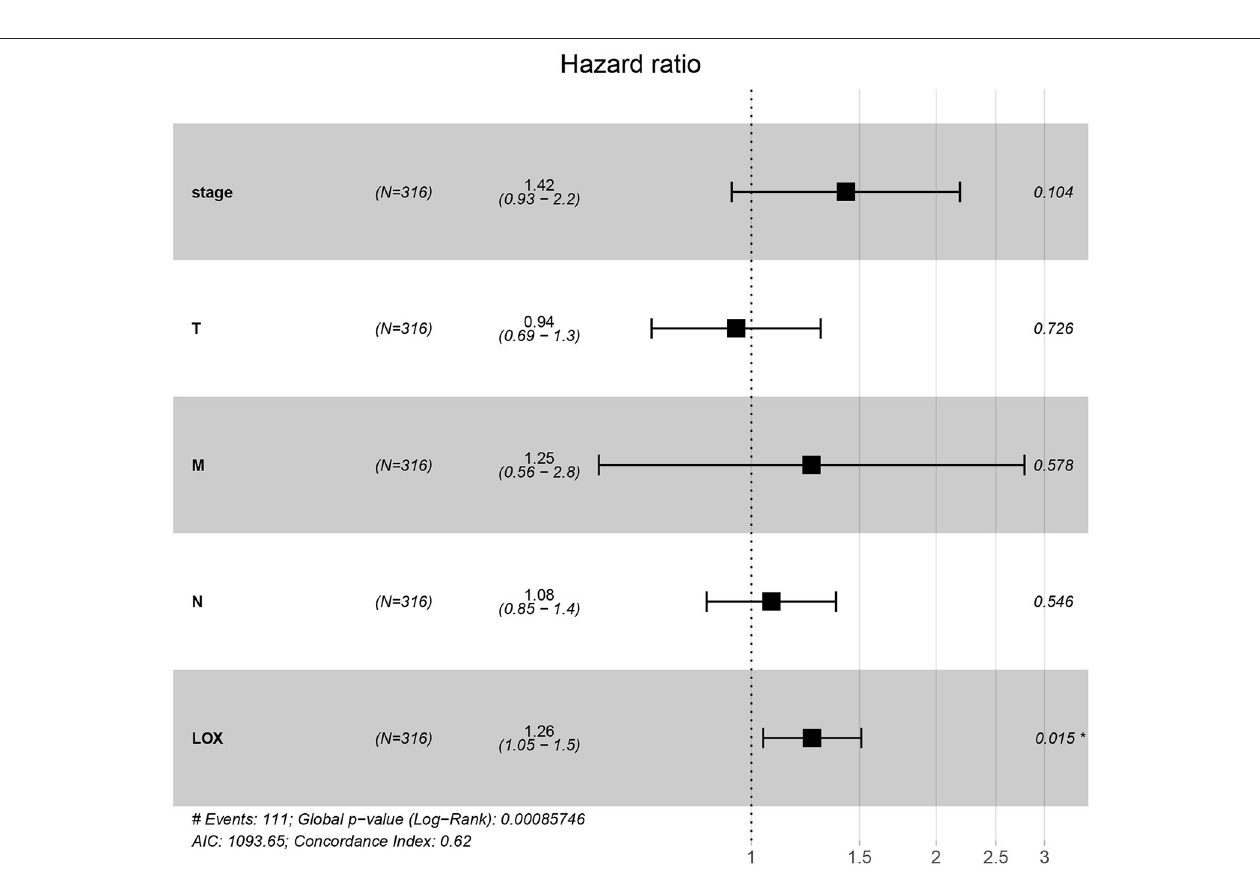
FIGURE 4 | Forest plot of the correlation between LOX expression and overall survival in GC patients based on TCGA data. TCGA, The Cancer Genome